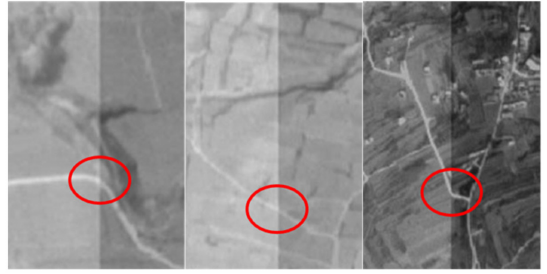
Figure 10. Zoomed views of forward/nadir/backward mosaic